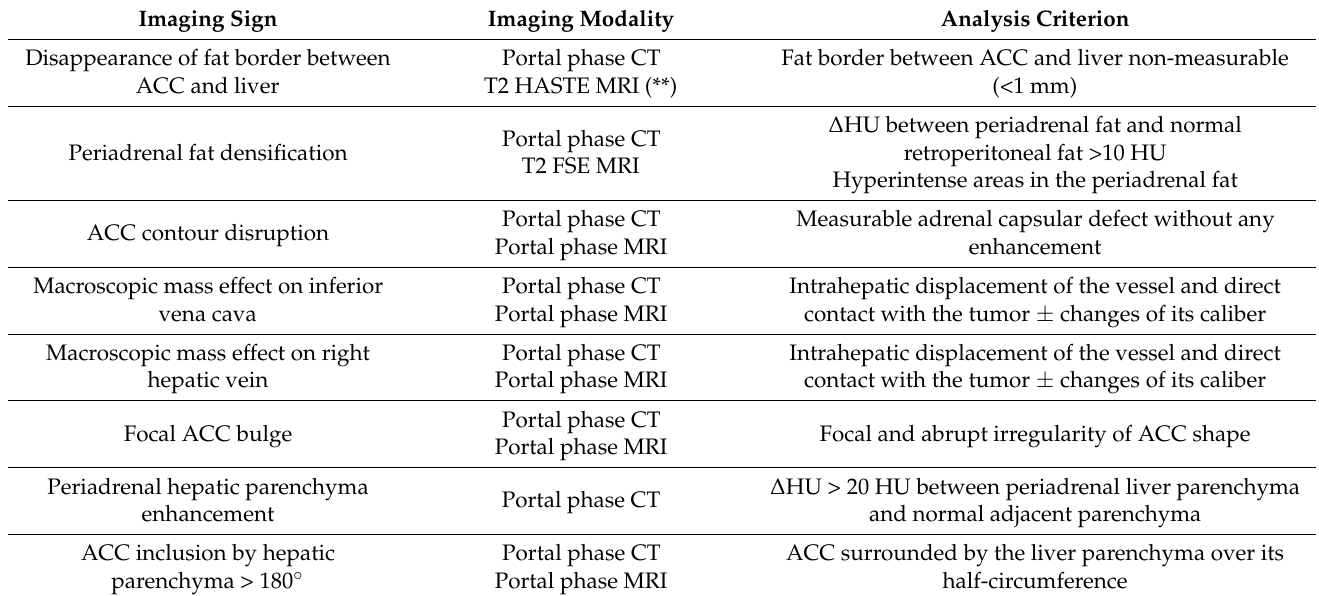
Table 2. Categorical reading criteria used on different imaging modalities (CT and MRI) in 29 patients with operated right-sided